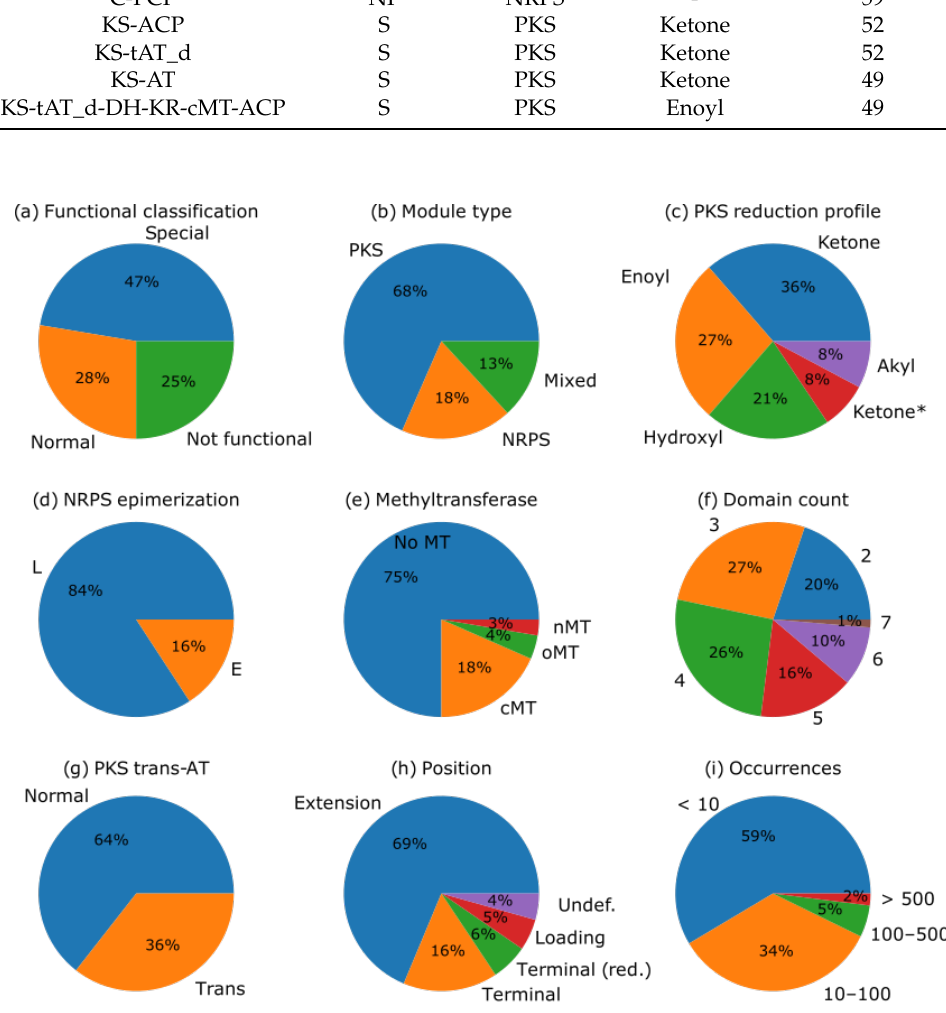
Figure 1. Summary of MIBiG module arrangements which occur at least twice in the MIBiG v2 database. The summary includes: functional classification ( a ) as explained in Section 4.2; module type ( b ), where mixed refers to modules which are composed of both PKS and NRPS domains (e.g., C-A-ACP); reduction profile of PKS modules ( c ), where the special reduction profile ketone * refers to modules in which reductive domains are present but the reduction cannot be performed because the KR module is missing (e.g., KS-AT-DH-ACP); epimerization of the NRPS module ( d ), where L refers to the L-configuration of the substrate and E refers to the R-configuration of the substrate; the presence of MTs ( e ); number of domains in the modules ( f ); classification of PKS modules into normal and trans-AT acting modules ( g ); position in the BGC ( h ); and number of overall occurrences in the database ( i ). Table 2. The 20 most common modules found in the MIBiG. The functional classification, normal (N), special (S), and not functional (NF) is explained in Section 4.2. The modification refers to the reduction profile of PKS modules or epimerization of NRPS modules. The occurrence refers to the overall count in all BGCs of the MIBiG v2.